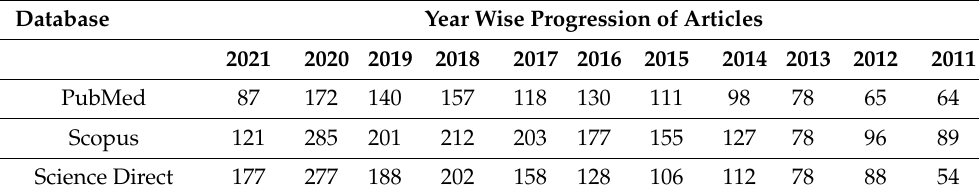
Table 1. Progression of thymoquinone article from the year 2011 to 2021.